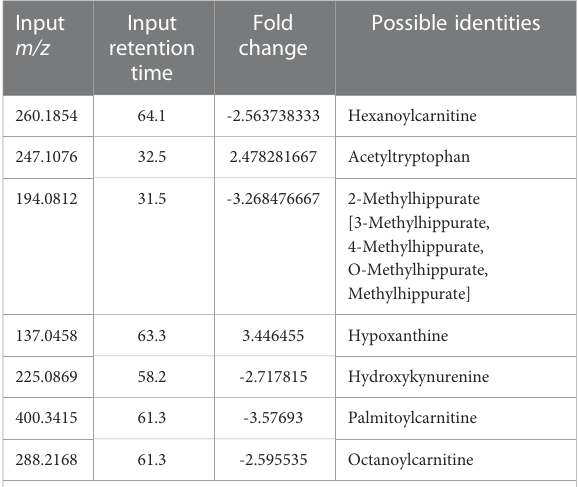
Possible identities indicated if within 0.02 m/z and 30 seconds of retention time. Isomers shown in brackets. Fold change re fl ects the difference between TP1 and